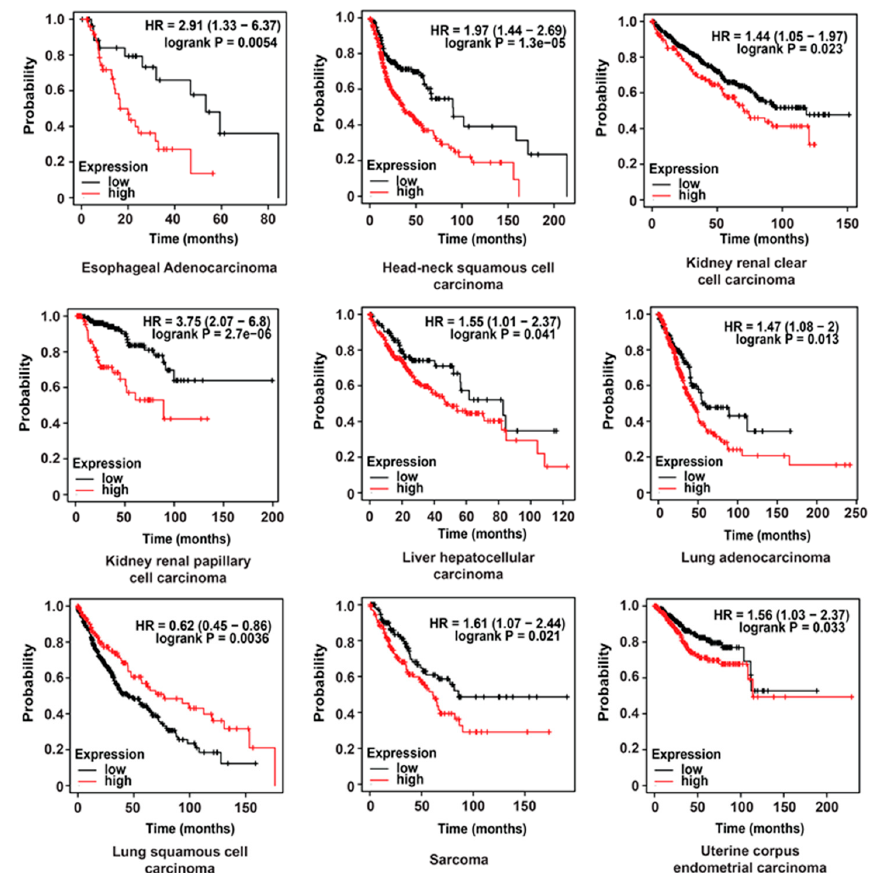
Figure 6. Clinical value of HPRT1 expression in cancers. Kaplan–Meier overall survival analyses of patients expressing higher (red line) or lower (black line) levels of HPRT1 RNA evaluated across pan-cancer types. The cancer outcome-linked gene expression data were accessed and graphed on 2 June 2020, using